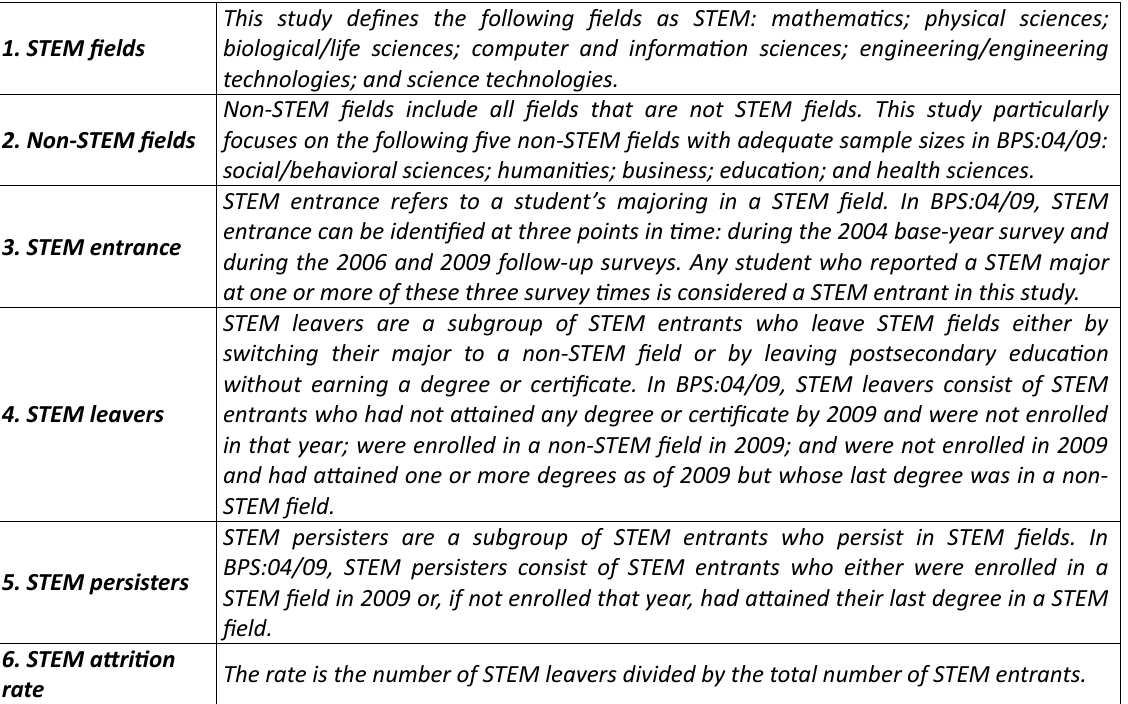
Table 1. Defniton of key terms related to